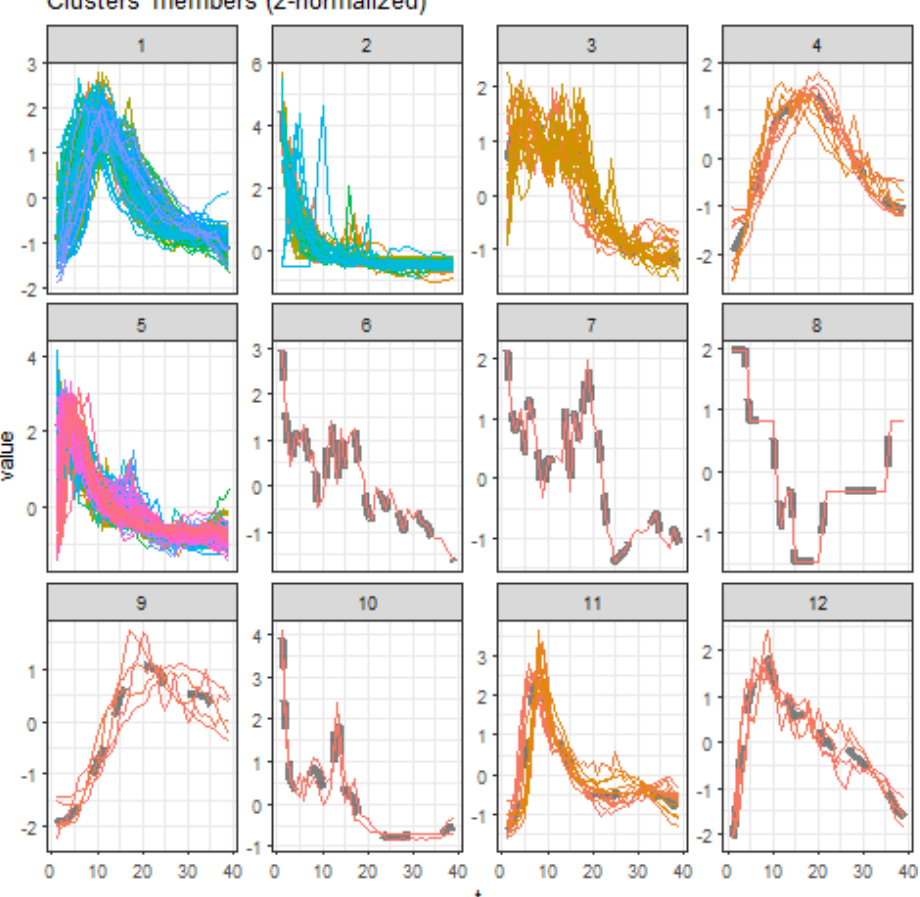
Figure 6. Streamflow Regime Types produced by clustering of the 395 standardized median 5d streamflows using dynamic time warping. The individual lines are coloured based on stationID; the consistency of colour reflects similar spatial locations. The heavy dashed line is the centroid of the cluster. Note that the number on the x axis is for the aligned series (1–39) as opposed to 23–61. The y -axis value is the z -score and differs in scale between the panels.